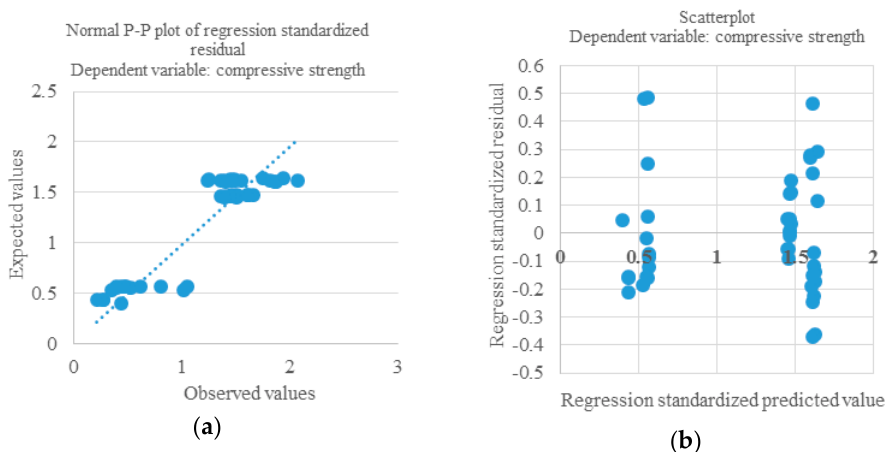
Figure 4. Normal probability plot of residuals for Model 4 (compressive strength). ( a ) Normal P-P plot of regression standardized residual; ( b ) Scatterplot.